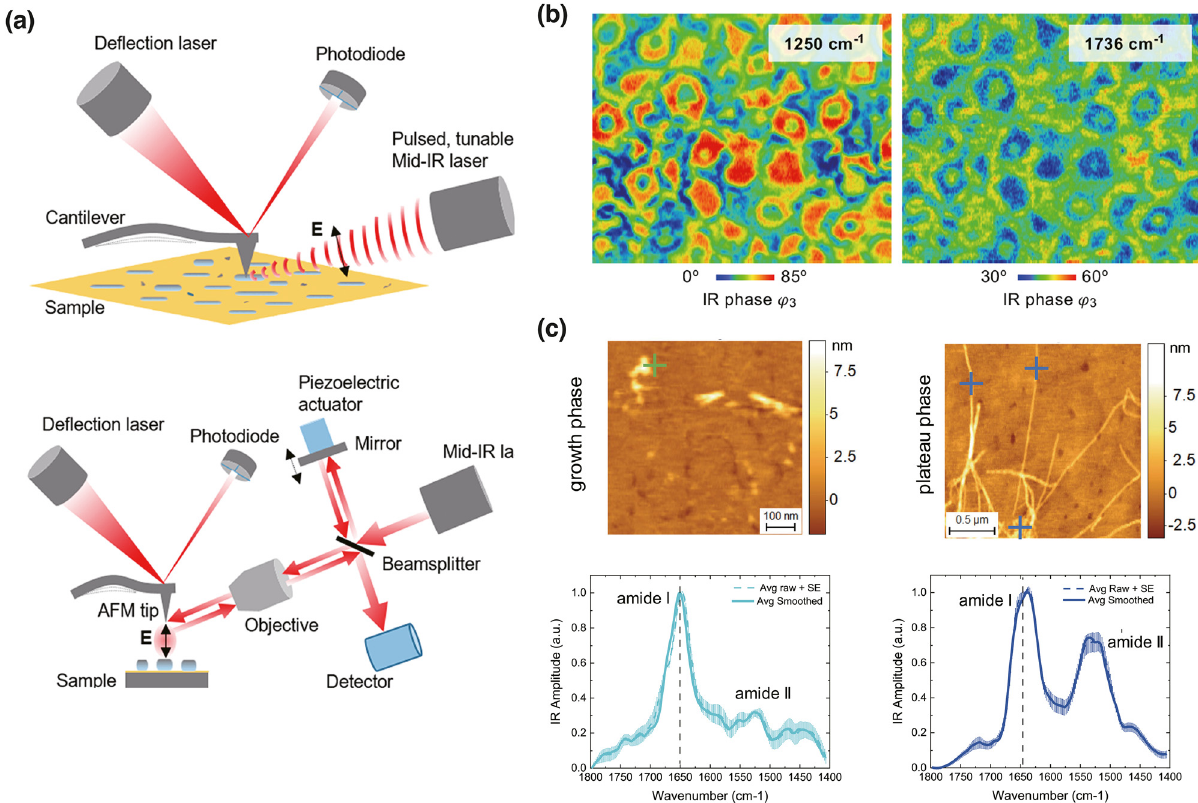
Figure 7: Principles and applications of infrared nanospectroscopy for polymer and biological samples of (a) Schematic of and atomic- force-microscopy-based infrared spectroscopy (AFM-IR) (top) and IR scattering-type scanning near-field optical microscopy (s-SNOM) with an asymmetric Michelson interferometer (bottom). (b) Topography of poly(perfluorooctyl acrylate-co-methyl methacrylate-co-butyl acry- late) copolymer and the corresponding nanoscale IR absorption, constructed by IR peaks at 1250 and 1736 cm − 1 , respectively. (c) Topog- raphy and AFM-IR spectra of single oligomeric (left hand side) and fi brillar species (right hand side) of A β 42. [(a) Reproduced